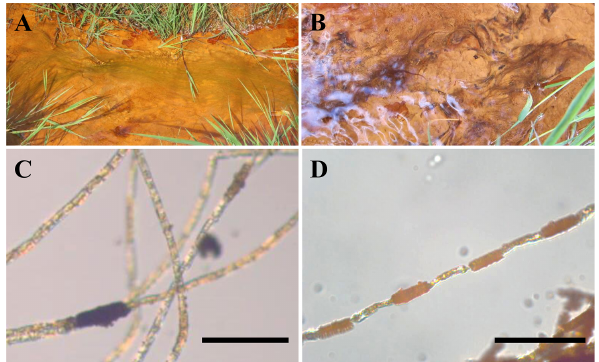
Figure 3. Photographs (a, b) and light microscopic pictures (c, d) of the green algae in site A (a, c) and the brown algae in site C (b, d) taken in July 2013. The microscopic pictures show Fe-mineral precipitates on the algae. Scale bars indicate